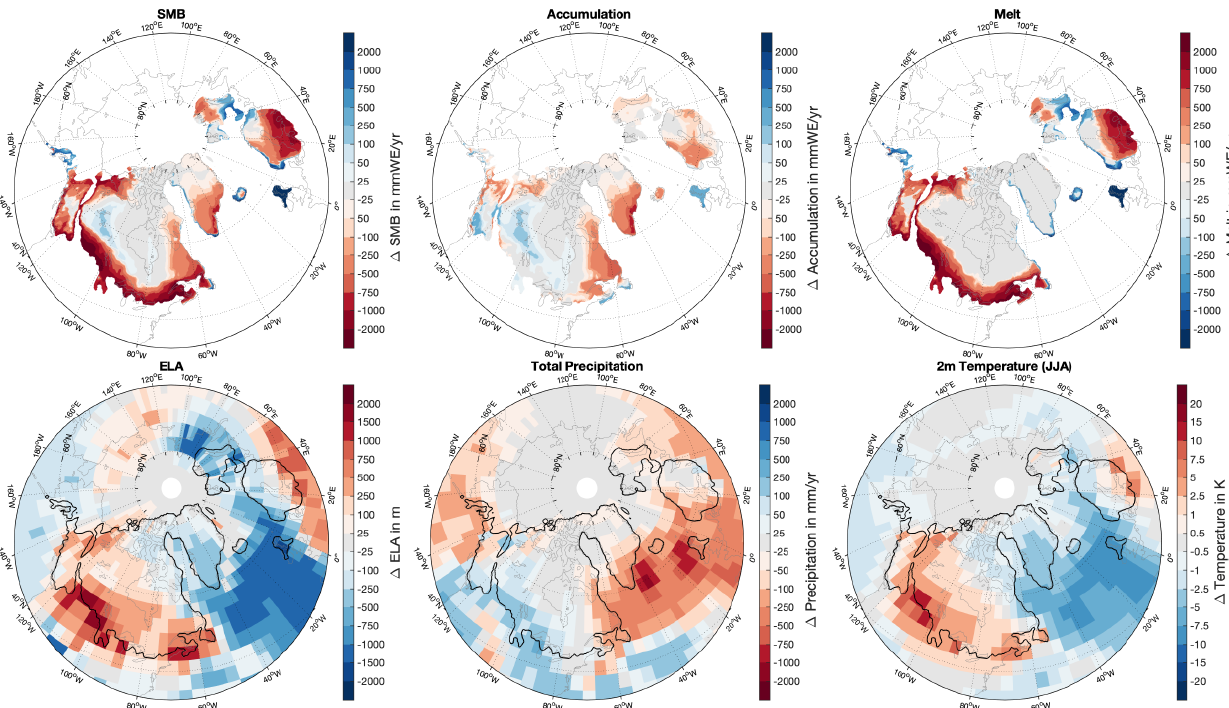
Figure A4. Similar to Fig. A3 but for differences between 14.4 and 15ka from MPI-ESM-CR Ice6G . Note that a different time slice was chosen compared to Fig. 6 due to a later AMOC slowdown in MPI-ESM-CR Ice6G compared to MPI-ESM-CR Glac1D .